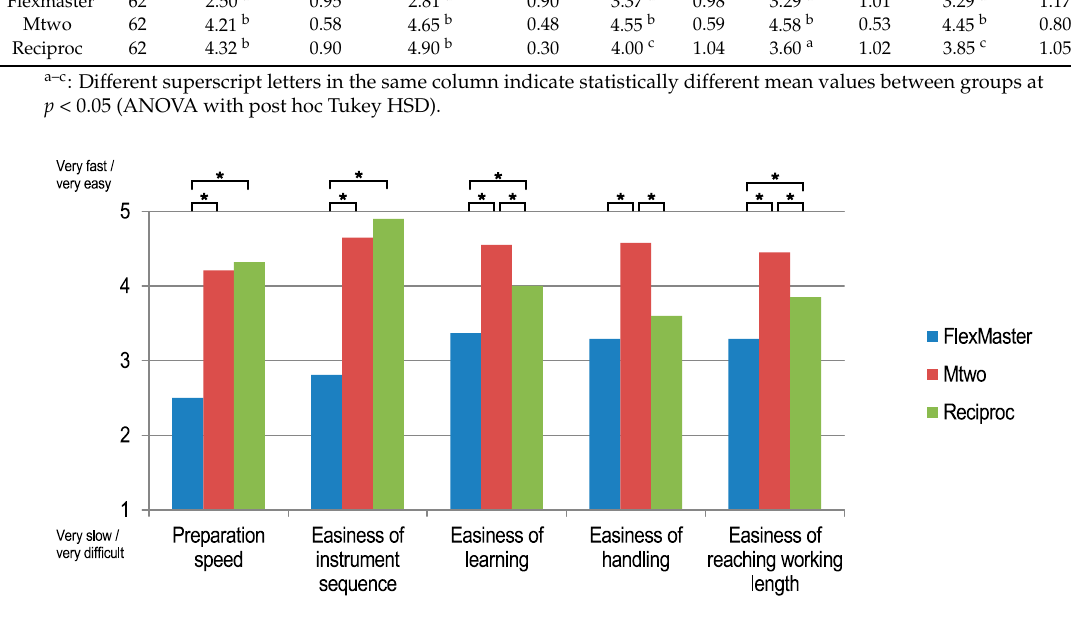
Figure 3. The students’ subjective questionnaire evaluation of the three root canal preparation strategies: crown-down (F), single-length (M) and single-file (R) (ANOVA with post hoc Tukey HSD; * indicates significant differences with p < 0.05 between groups).